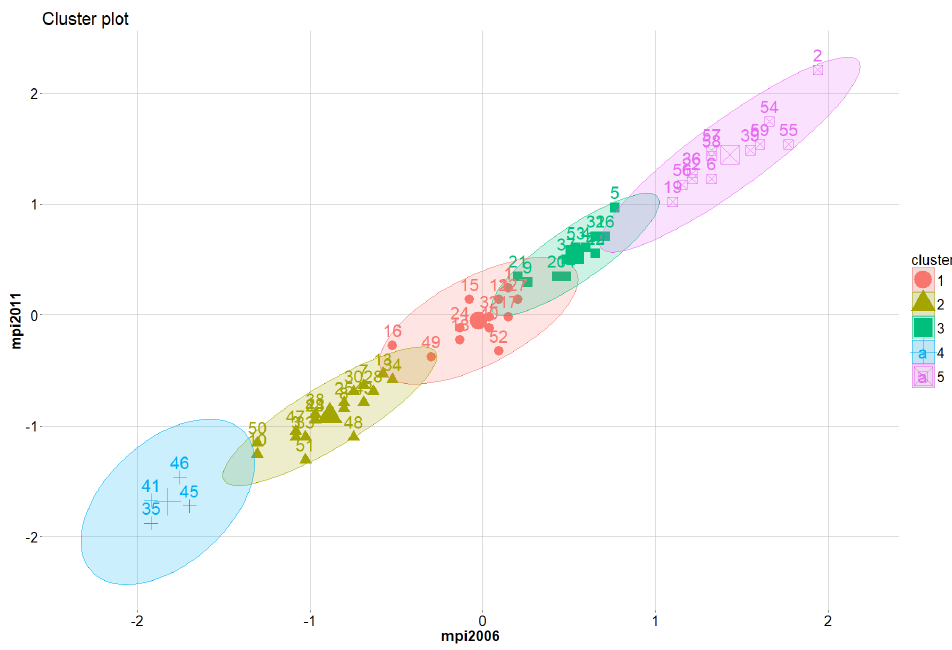
Figure 4: Scatter plots for k-means clusters’ solutions – k = 5